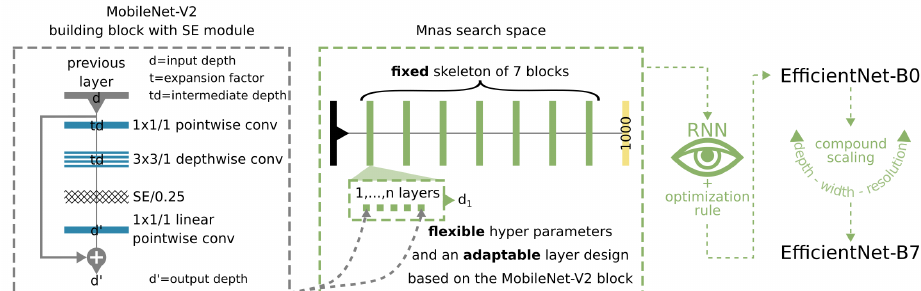
Figure 8. Conceptual overview of the Efficient designs : ( Left ) The MobileNetV2 building block [108], here with an additional Squeeze-and-Excitation (SE) module [47]. In comparison with a ResNet building block, the bottleneck design is inverted, so that first the expansion factor (t) is larger than 1, which leads to intermediate deeper feature maps (td) as the final output depth of the building block (d’). ( Middle ) The Mnas search space with a fixed overall architecture of the network, the skeleton, but fully optional layer designs, based on the MobileNetV2 building block [51]. ( Right ) A recurrent neural network (RNN) [34] controller searches the search space for the best performing combination of layer designs by maximising an optimisation rule [48]. The resulting architecture is scaled in depth, width and resolution to become the EfficientNet-B7 architecture, the sota design in late 2019